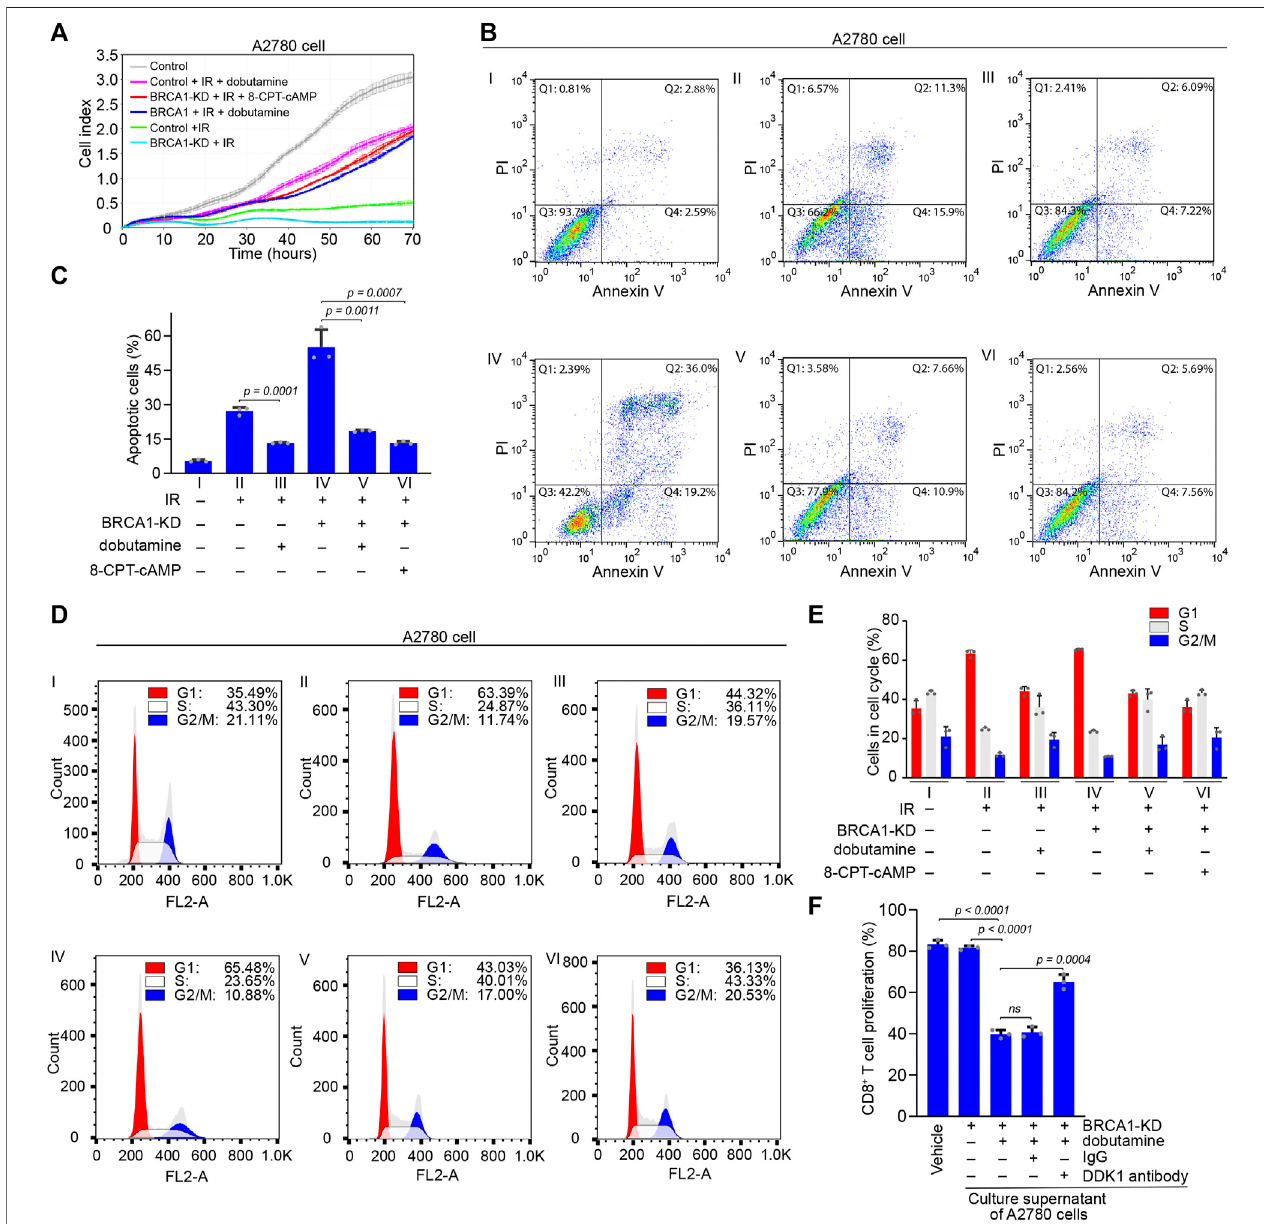
FIGURE 5 | The effects of cAMP on apoptosis of BRCA1 knock-down ovarian cancer cells and proliferation of CD8 + T cells. (A) Control and BRCA1 knock-down A2780 cells were treated with or without dobutamine or 8-CPT-cAMP before IR irradiation, and the proliferation of these cells was monitored using the xCELLigence RTCAsystem.Cellproliferationwasautomaticallymonitored70 h(i.e.,untilthecontrolcells reachedagrowth plateau). Controlcellsareshown by greyline,IRirradiated controlandBRCA1knock-downcellsareshownbygreenandcyanlines,dobutaminepre-treatedcontrolandBRCA1knock-downcellsirradiatedbyIRareshown bypinkandbluelines,8-CPT-cAMPpre-treatedBRCA1knock-downcellsirradiatedbyIRareshownbyredline.Errorbarsrepresentthestandarddeviation. (B) Control and BRCA1 knock-down A2780 cells were treated with or without dobutamine or 8-CPT-cAMP before exposed to 10 Gy IR. After 18 h, cell apoptosis analysis was performed through fl ow cytometry. Ⅰ : control cells without IR treatment, Ⅱ : control cells with IR treatment, Ⅲ : dobutamine pre-treated control cells with IR treatment, Ⅳ : BRCA1knock-down cellswithIRtreatment, Ⅴ :dobutamine pre-treatedBRCA1 knock-downcellswithIRtreatment, Ⅵ :8-CPT-cAMPpre-treatedBRCA1 knock-down cellswithIRtreatment.Q1:necroticcells,Q2:earlyapoptoticcells,Q3:lateapoptoticcells,Q4:viablecells. (C) PercentagesofapoptoticA2780cells,includingearlyand lateapoptoticcells,ineachgroupfrom (B) .Threebiologicallyindependentreplicateswereperformed.Dataarepresentedasmeanvalues±SD. p valueswerecalculated by unpaired two-tailed Student ’ s t -tests. (D) Cell cycle analysis was performed to detect the effects of dobutamine or 8-CPT-cAMP on cells that were treated as describedin (B) through fl owcytometry. G1phase: red, Sphase: white,G2/Mphase: blue. (E) Percentages ofG1phase, Sphase, and G2/Mphase cellsin each group from (D) . Three biologically independent replicates were performed. Data are presented as mean values ±SD. (F) The inhibitory effect of secretion of dobutamine pre- treated BRCA1 knock-down A2780 cells on the proliferation of CD8 + T cells in vitro . The proliferation of the cells was determined by CFSE dilution. Three biologically independent replicates were performed. Data are presented as mean values ±SD. p values were calculated by unpaired two-tailed Student ’ s t -tests.